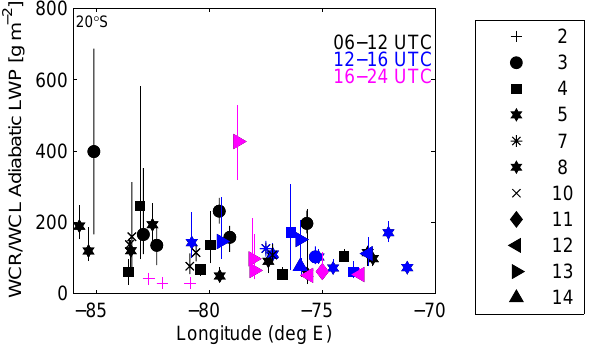
Fig. 15. WCR/WCL-derived adiabatic LWP for 20 ◦ S C130 sub- cloud legs, using flight-specific symbols and color-coded by time of day. Each symbol shows the leg-median LWP, and the vertical lines show the interquartile range of the 1Hz data for that